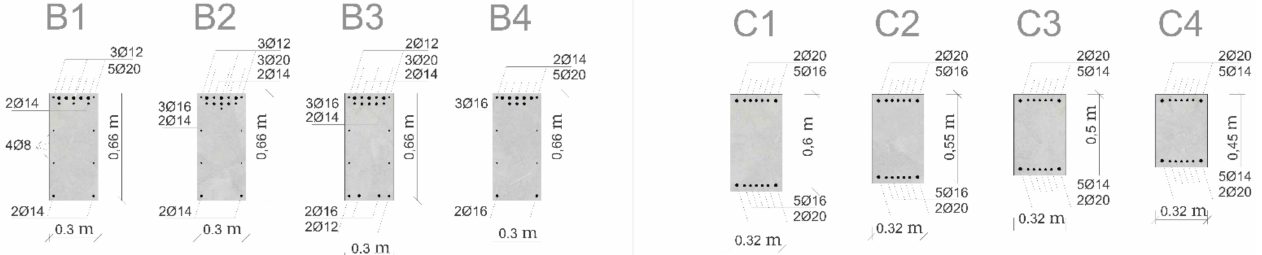
Figure 6. Columns (C) and beams (B) cross-sections and longitudinal reinforcement